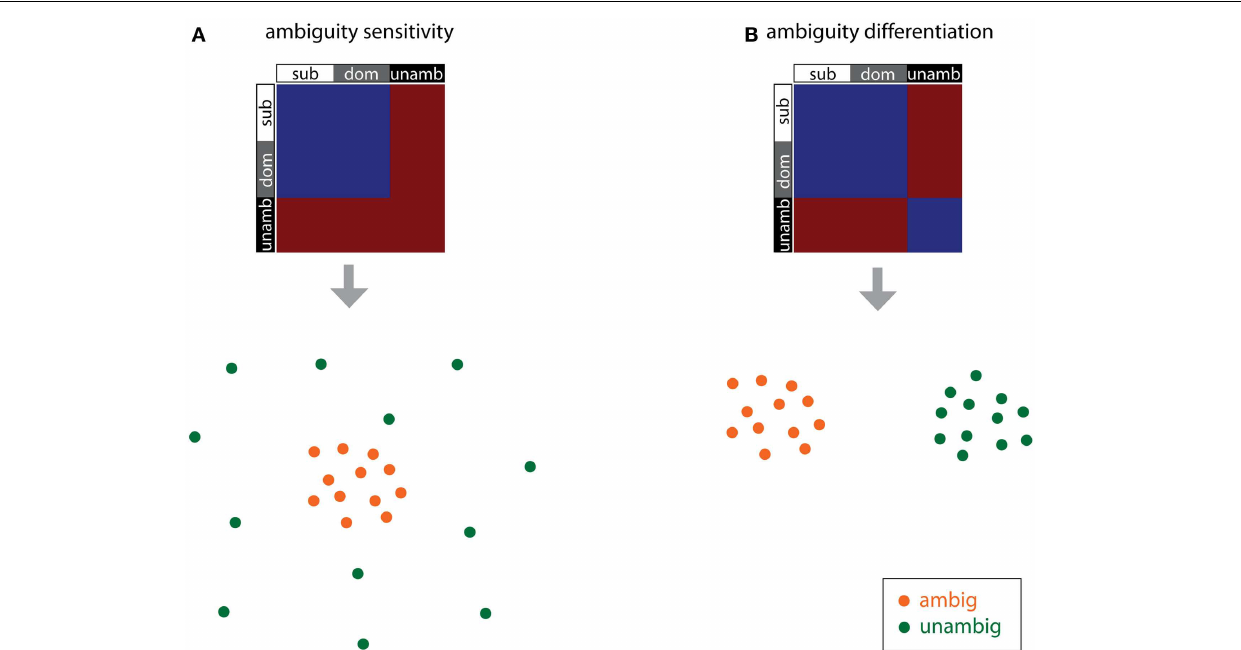
FIGURE 3 | RDMs and corresponding cartoon multidimensional scaling plots for the ambiguity sensitivity and ambiguity differentiation models . (A) The ambiguity sensitivity RDM tests the hypothesis that a distinct pattern of neural activity, associated with the processing of multiple syntactic parses, arises for the ambiguous items (i.e., the subordinate and dominant conditions).This pattern of neural activity does not arise for unambiguous